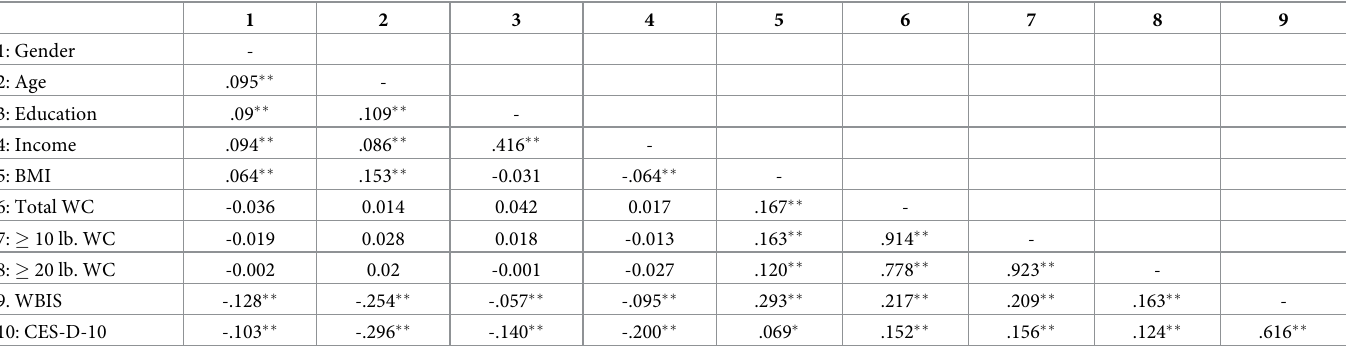
Table 2. Bivariate correlations.